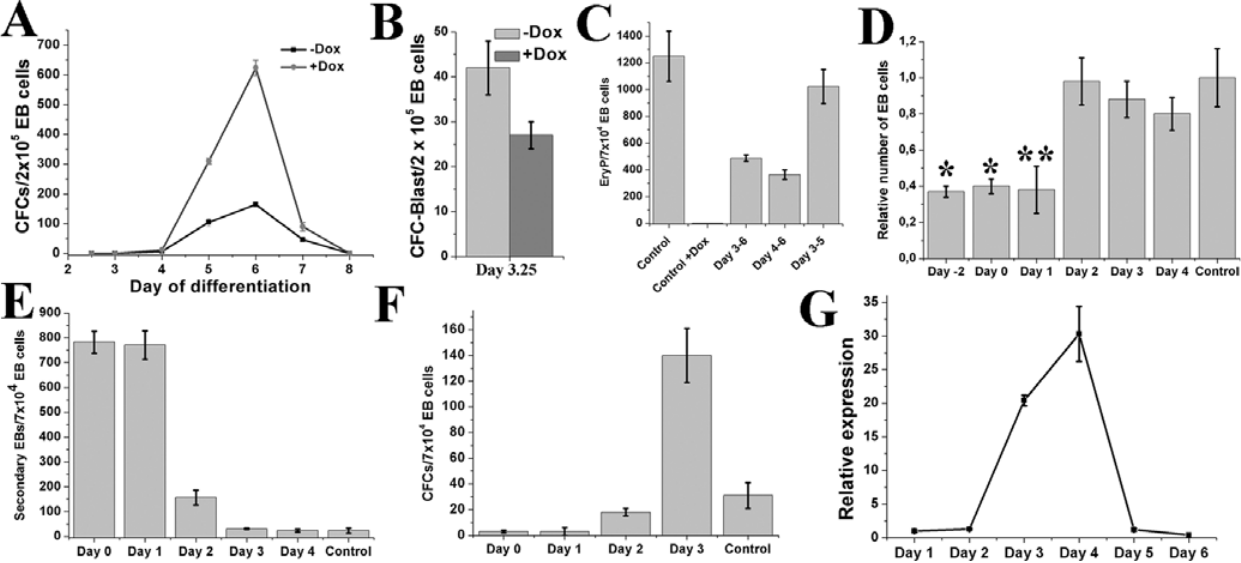
Figure 5. Analyses of the effect of Lhx2 expression at different stages of ES cell differentiation. A. Frequency of definitive CFCs in EB cells generated from the iLhx2 ES cells at the indicated days of differentiation starting at day 2,5 analysed in clonal assays in the absence ( 2 Dox) or presence ( + Dox) of dox. B. Frequency of CFC-Blast in day 3,25 EBs analysed in clonal assays with SCF and VEGF in the absence ( 2 Dox) or presence ( + Dox) of dox. C. Frequency of EryP precursor cells in day 6 EBs if dox is added during the indicated time points of ES cell differentiation and omitted in the clonal assays, compared to when no dox is added (Control) or if dox is added to clonal assays of control EBs (Control + Dox). The latter two control experiments are equivalent to the experiments shown in Figure 2A using the iLhx2 ES cells. D. Relative number EB cells recovered at day 6 of differentiation if dox is added to the iLhx2 ES cell line at the indicated time points during differentiation compared to when EBs are generated in the absence of dox (Control) which is arbitrarily set as 1. * p , 0,005 compared to control. ** p , 0,01 compared to control. E. Frequency of formation of secondary EBs in clonal assays of day 6 EBs if dox is added at the indicated time points during differentiation. Control EBs are generated without dox. F. Frequency of definitive CFCs in day 6 EBs when dox is added at indicated days of differentiation. Control EBs are generated without dox. G. Relative expression of the Brachyury gene during differentiation of the iLhx2 ES cell line revealing the progression of the gastrulation process in this particular ES cell line during differentiated in vitro